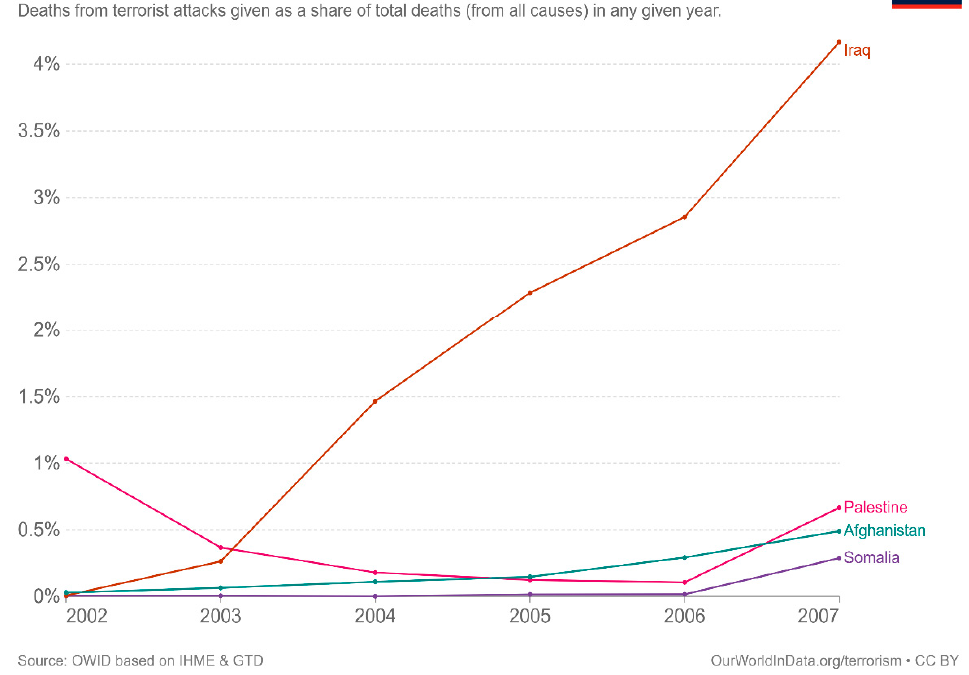
Figure 1. Development of fatalities of terrorism, relative to total deaths in Iraq compared to Palestine, Afghanistan, and Somalia, between 2002 and 2007.